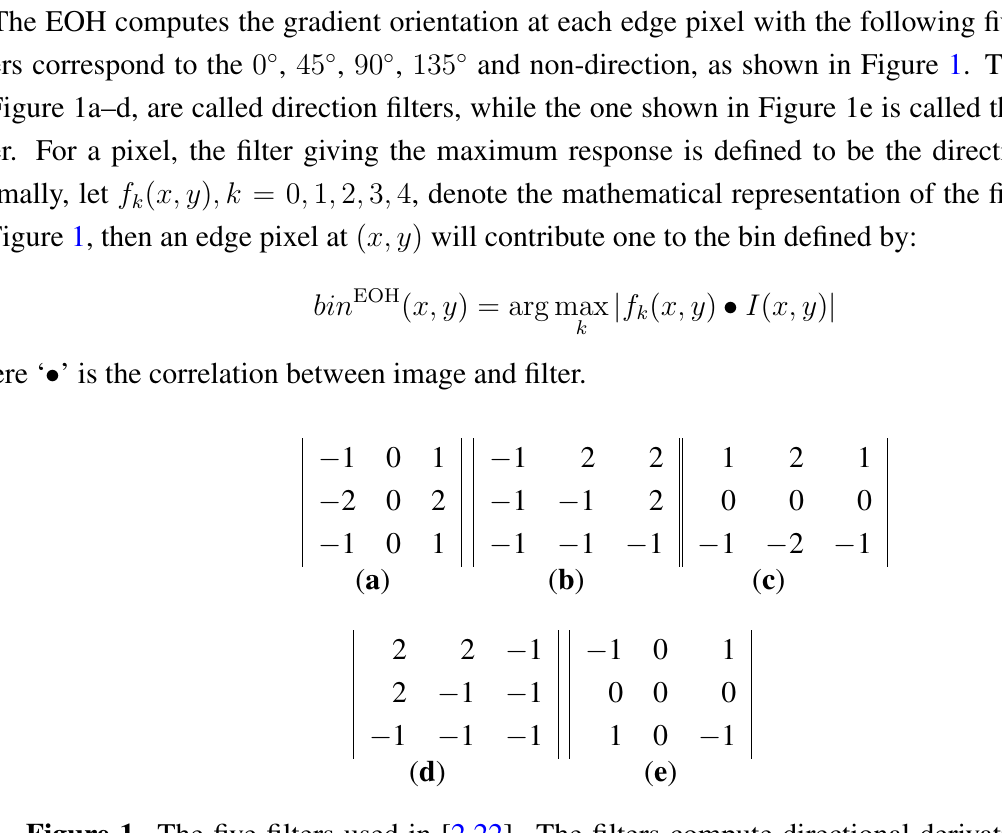
Figure 1. The five filters used in [2,22]. The filters compute directional derivatives in 0 ◦ , 45 ◦ , 90 ◦ , 135 ◦ and the non-direction showed in ( a – d ) and ( e ) respectively. ( a – d ) are the direction filters and ( e ) is the non-direction